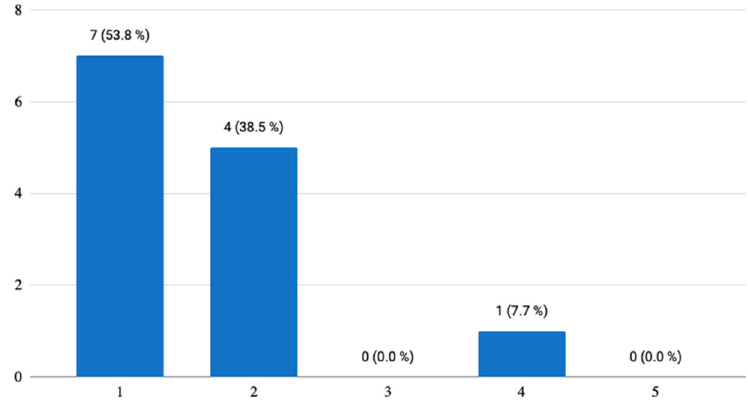
Figure 7. Seniors’ expectations of the mobile application.